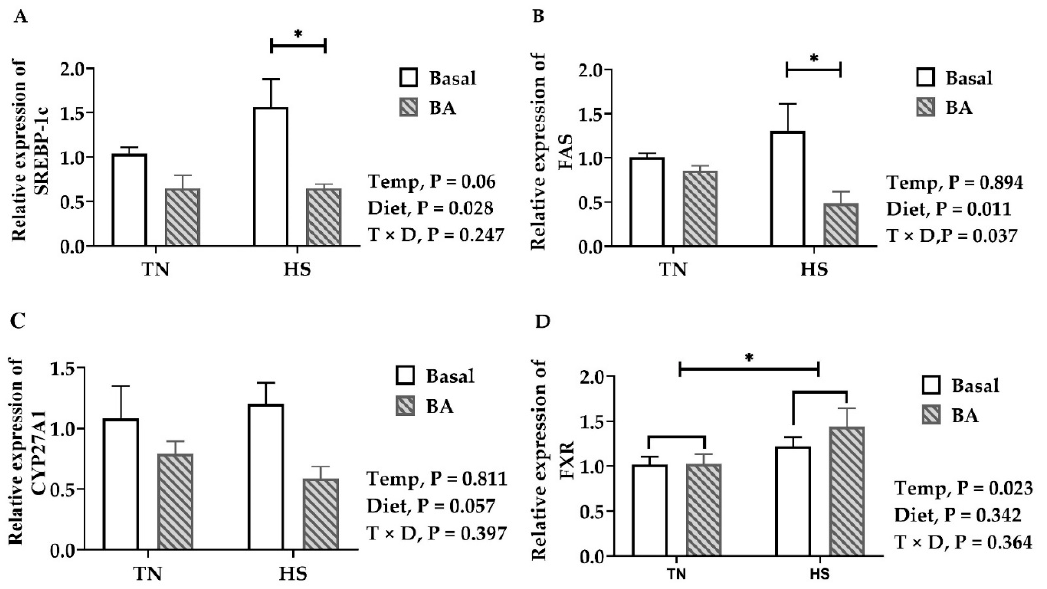
Figure 6. Gene expressions in the liver of broilers fed with 0 or 200 mg/kg bile acids under thermoneutral (TN) and heat-stressed (HS) conditions. ( A ) SREBP-1c, sterol regulatory element-binding protein 1c ; ( B ) FAS, fatty acid synthase; ( C ) CYP27A1, sterol 27-hydroxylase; ( D ) FXR, farsenoid x receptor. Data are the means ± SEM (n = 6 for each group). * p < 0.05.